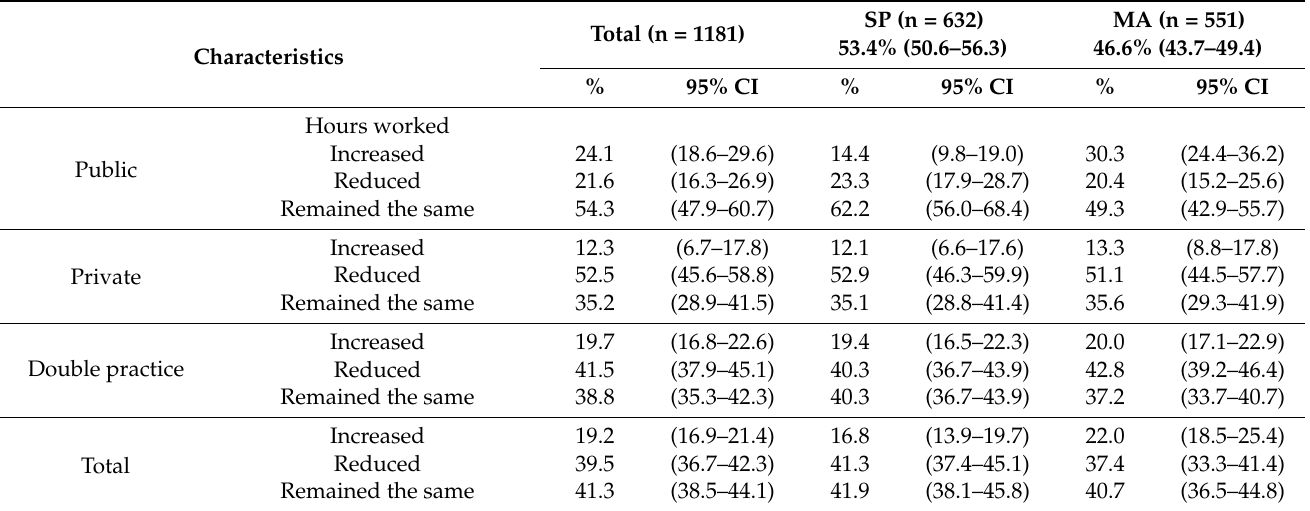
Table 4. Perceptions of the impacts of the COVID-19 pandemic on income patterns among physicians interviewed in SP and MA, Brazil,